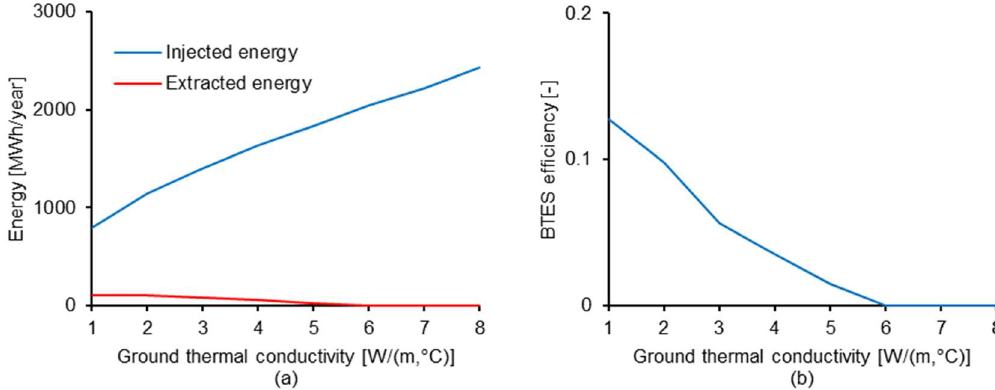
Figure 16. Annual injected and extracted energy ( a ) and BTES efficiency ( b ) as a function of ground thermal conductivity for the actual storage supply flow at heat injection, Case 6.